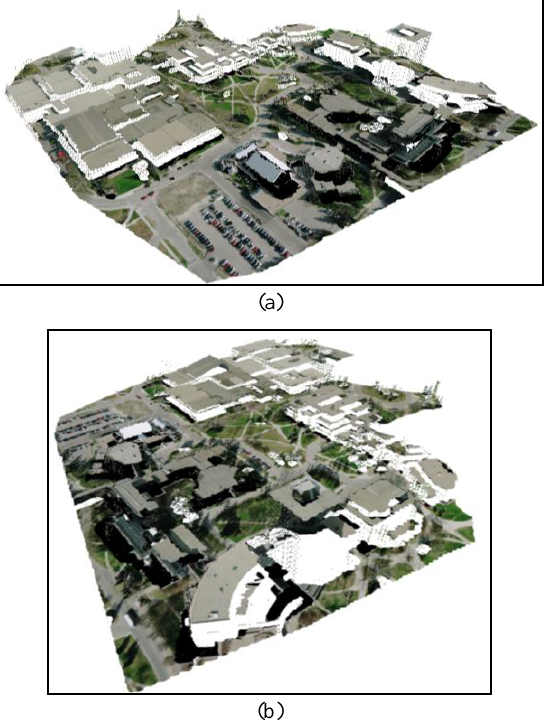
Figure 15. (a, b) Two different views from the textured planar regions and individually colored non-segmented